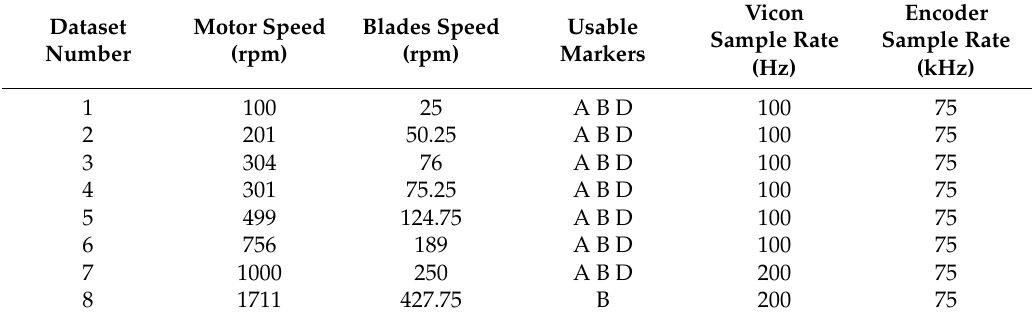
Table 2. Dataset collected with the rotor setup.